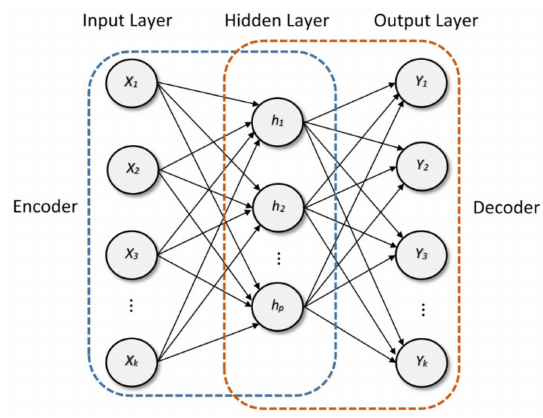
Figure 1. Structure of a single-layer auto-encoder with its corresponding encoder and decoder